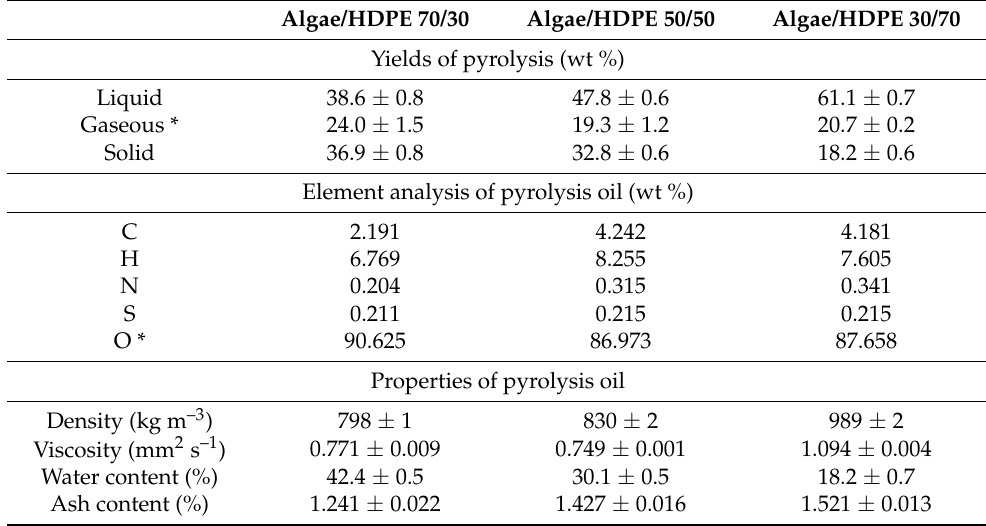
Table 3. Properties of co-pyrolysis oils from the macroalgae Cladophora glomerata and the HDPE waste at 350 ◦